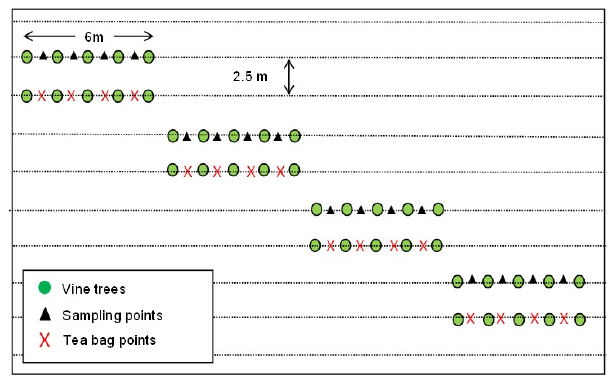
Figure 2. Sampling design at each